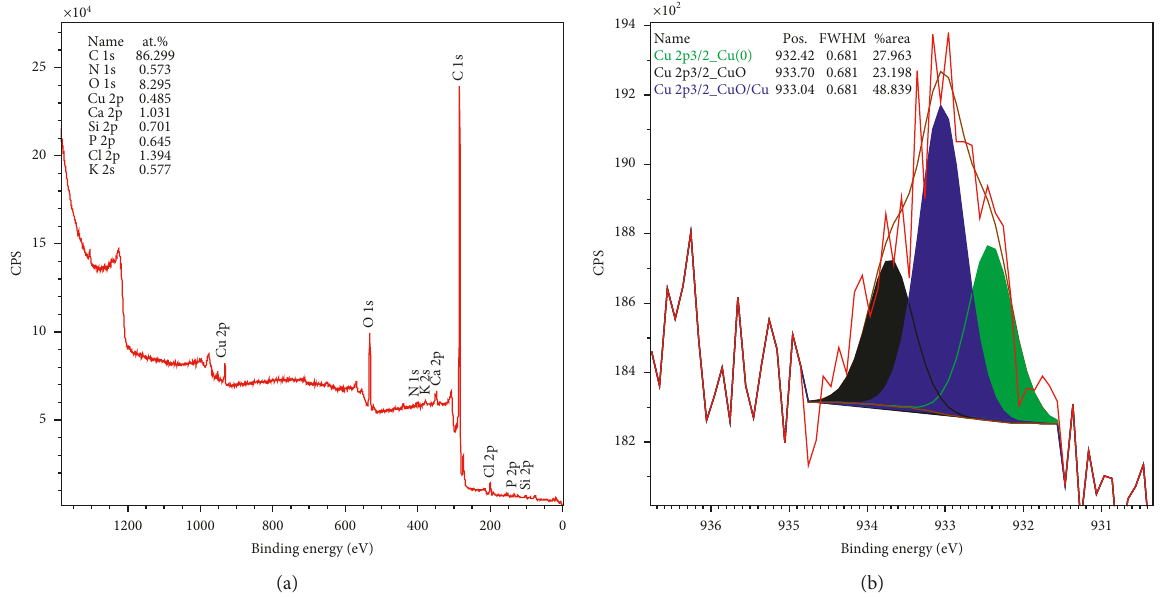
Figure 8: Survey photoelectron spectra of wheat straw pyrolysis solid carbon residue in the presence of CuCl photoelectron spectra of the Cu 2p3/2 sublevel (b).